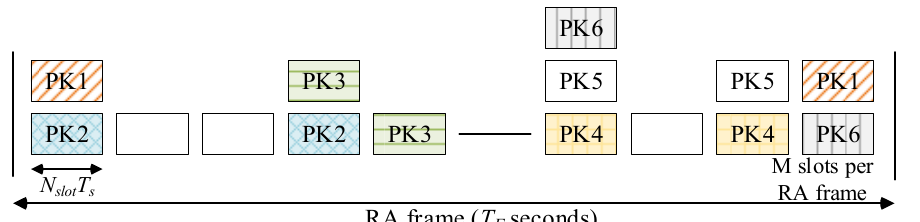
Figure 5. The working principle of CRDSA.